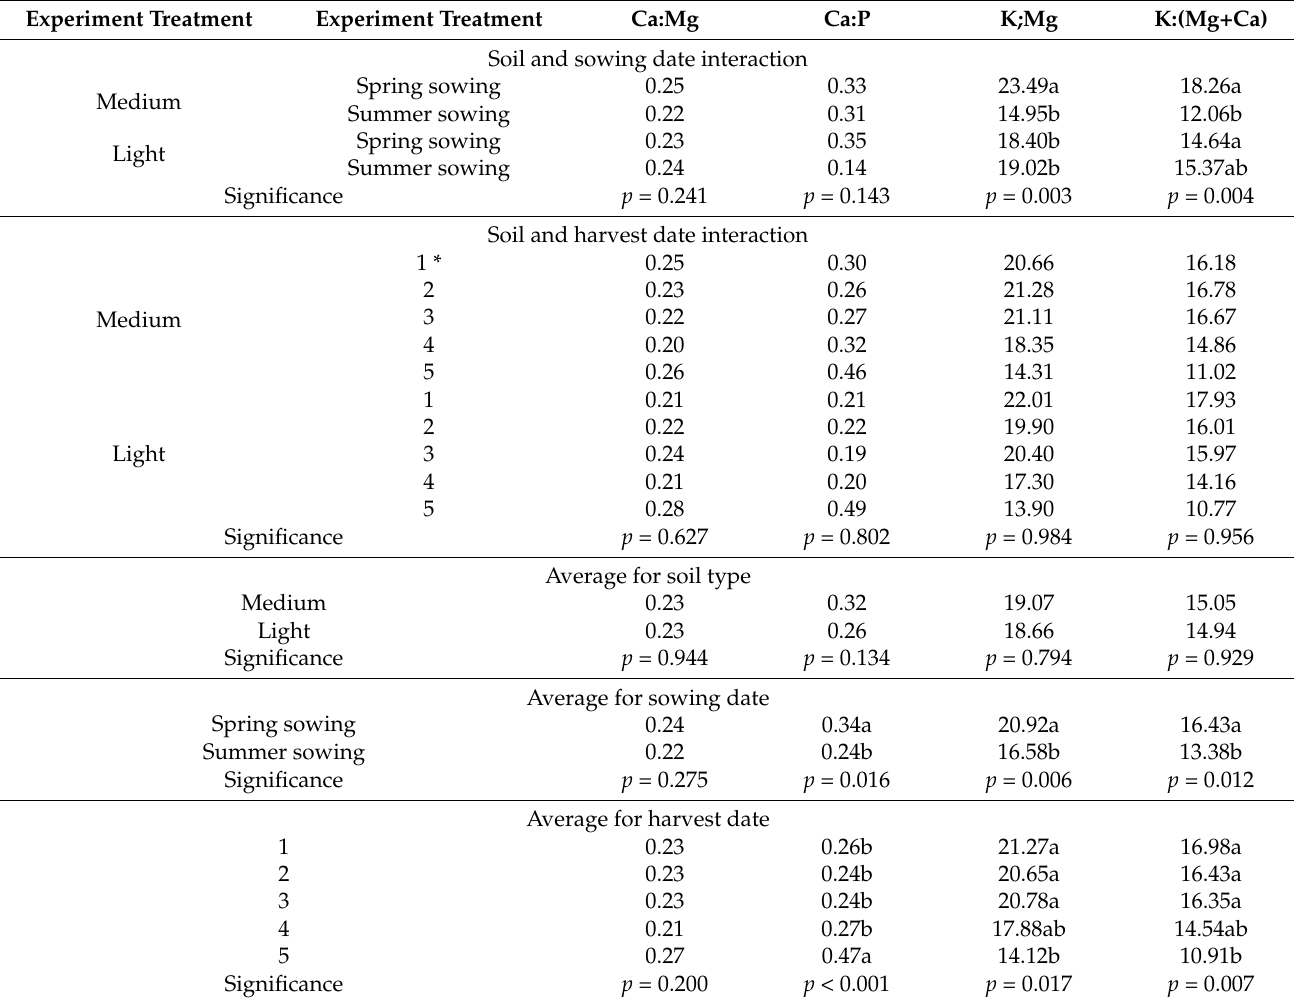
Table 7. The effect of soil type, sowing date and harvest date on quinoa minerals molar ratio. Average from years 2015–2017. Experiment